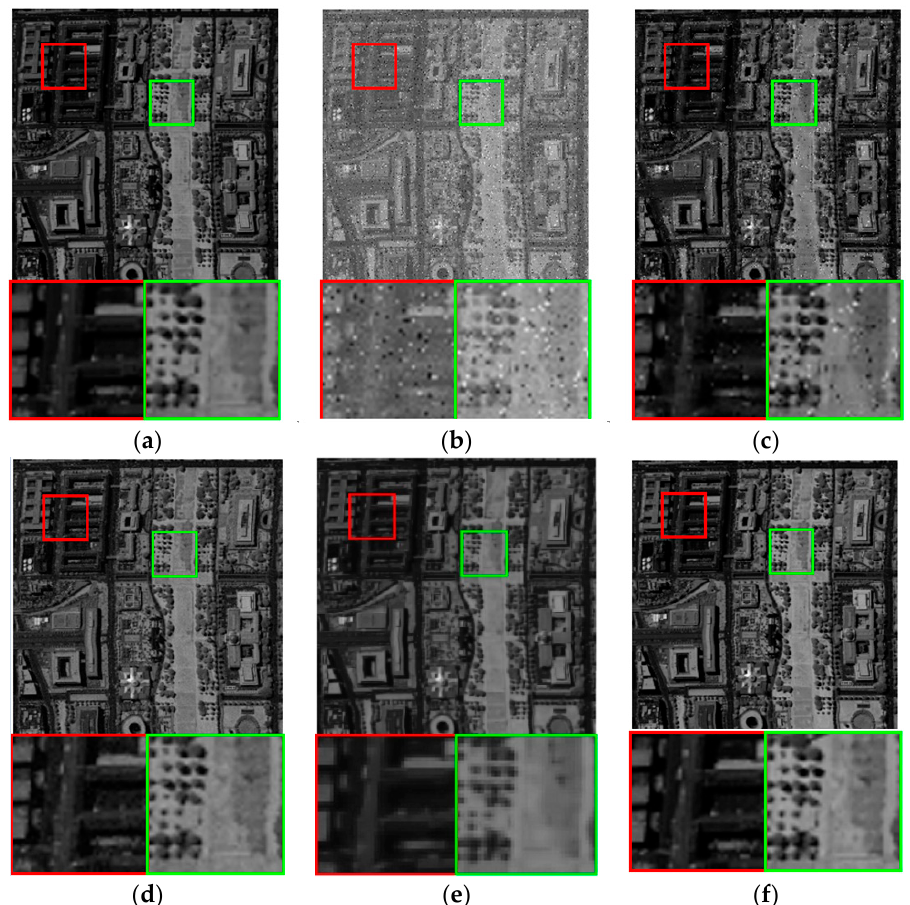
Figure 3. Visual comparison on band 2 of Washington dataset: ( a ) Clean/noise-free image band, ( b ) Noisy band, ( c ) Restoration result from VBM3D, ( d ) Restoration result from Godec, ( e ) Restoration result from SLrank, ( f ) Restoration result from the proposed method.